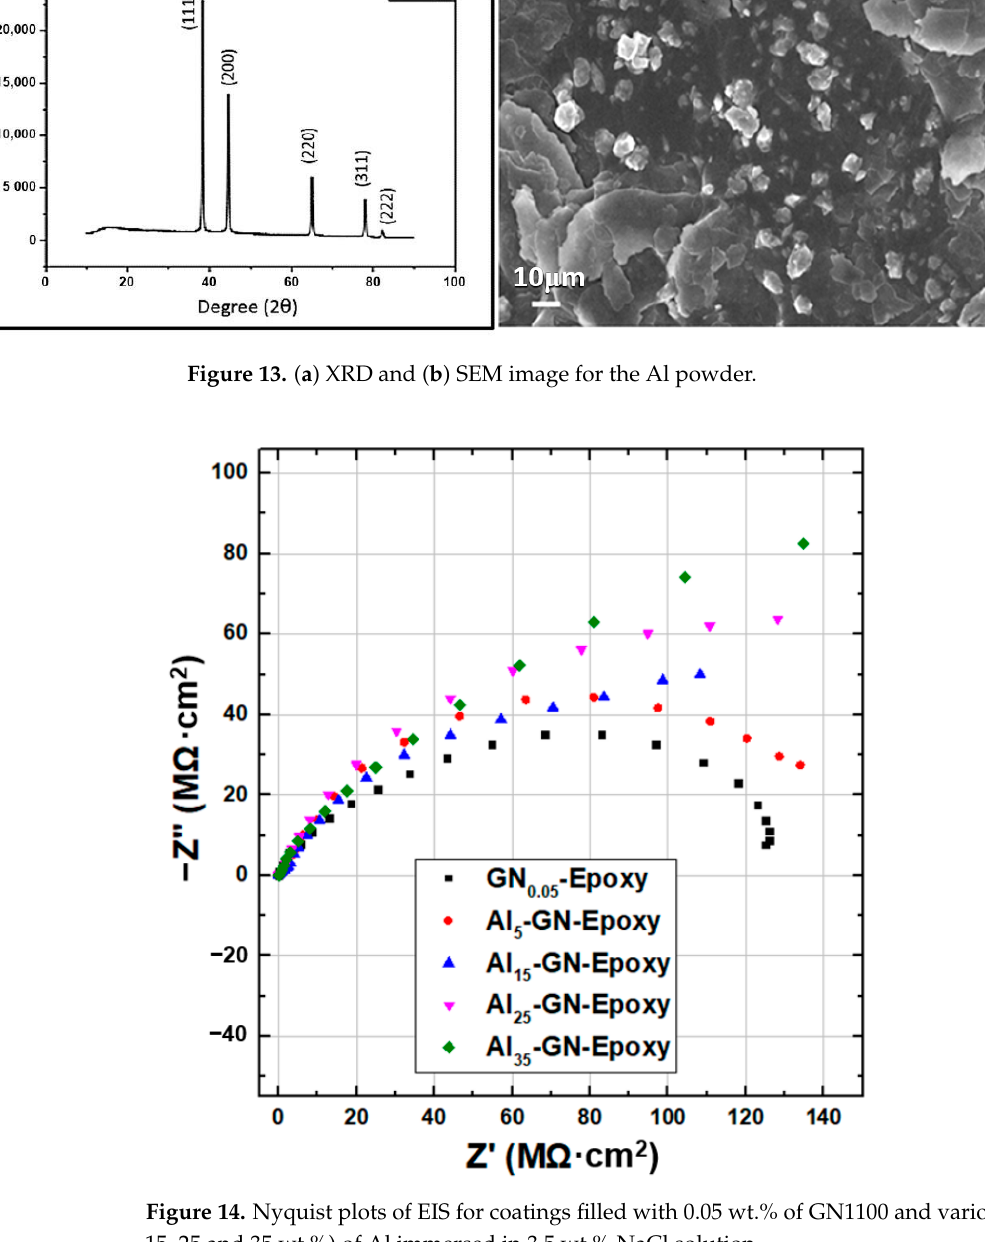
Figure 13. ( a ) XRD and ( b ) SEM image for the Al powder.